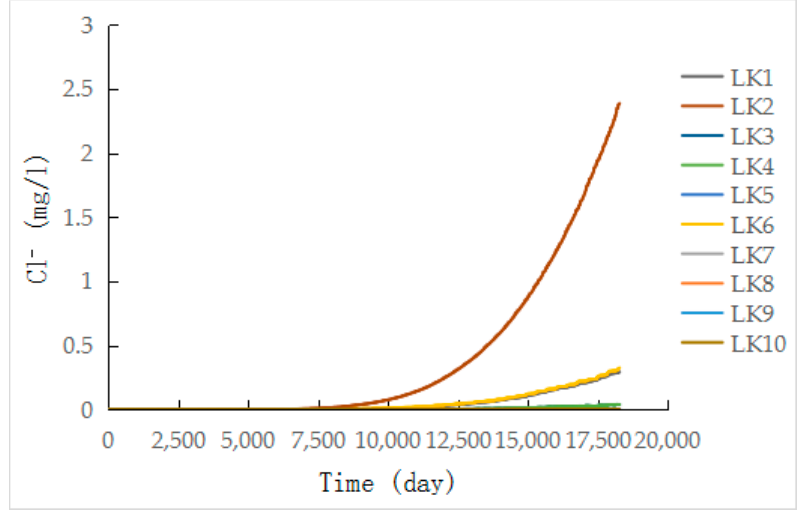
Figure 6. The concentration curve of Cl − .